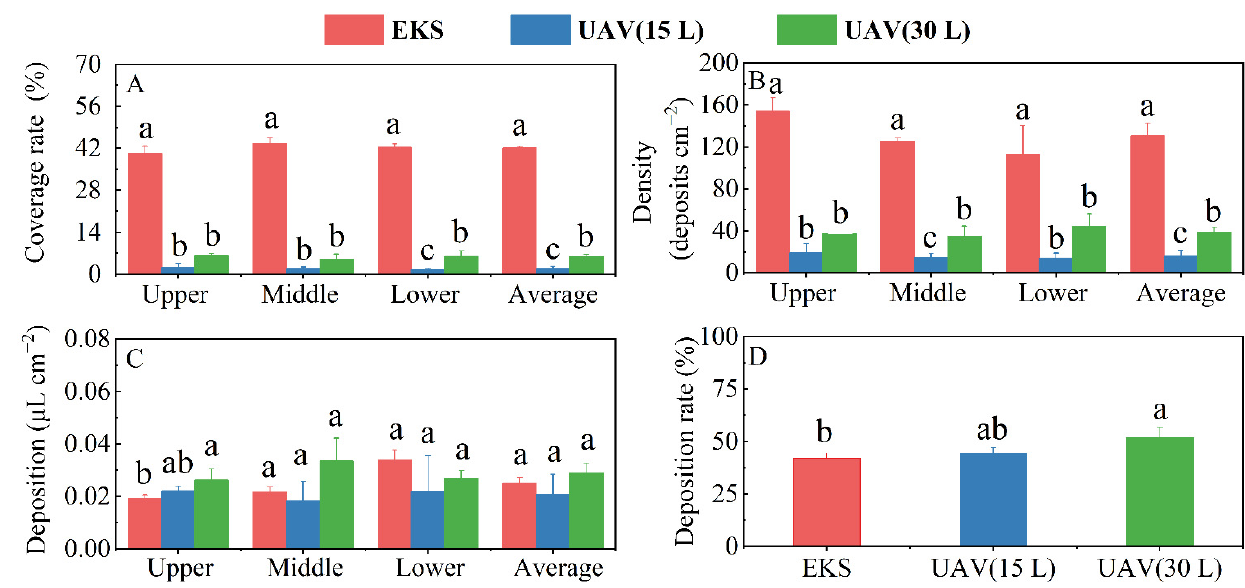
Figure 4. Droplet deposition distribution in different canopy in 2020. ( A ) The droplet coverage rate. ( B ) The droplet deposition density. ( C ) The droplet deposition. ( D ) The droplet deposition rate. Up- per, middle and lower are the leaf position. The spray volume for EKS, UAV (15 L), and UAV (30 L) was 450, 15, and 30 L ha − 1 , respectively. One-way ANOVA followed by Tukey test was used, and different letters above the bars indicated the significant differences ( p < 0.05) among treatments. Bars are the standard deviation of three replications.